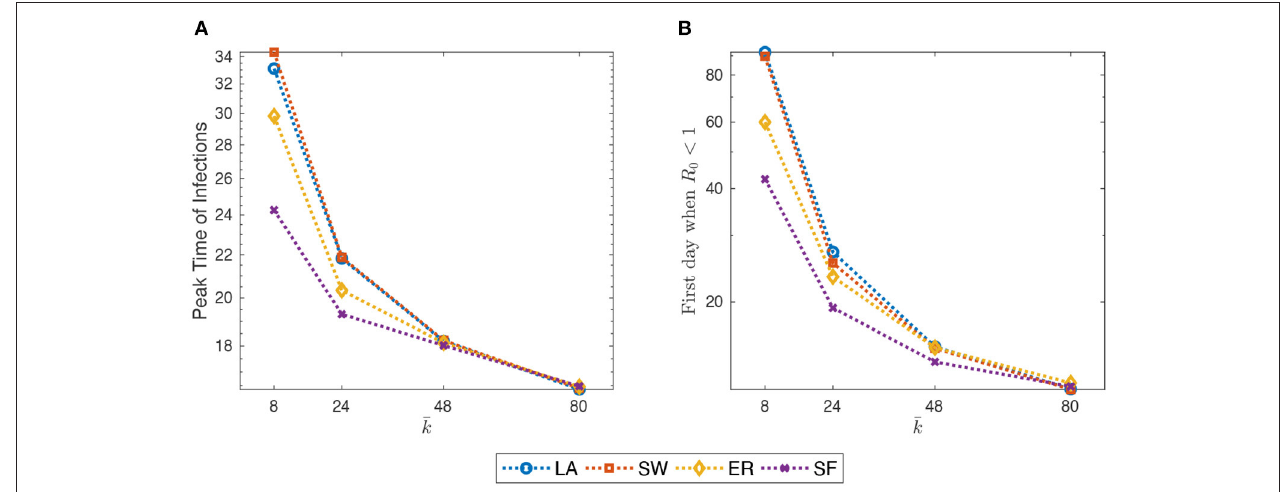
FIGURE 3 | (A) Peak-time of infections (PTI), defined as the first day in which the share of infected people reach its overall maximum, against initial average degree. (B) estimate of the first day after which ¯ ρ goes below one (cf. Supplementary Section S3 ). Initial average degree in the range { 8,24,40,80 } . Mid-impact epidemic scenario. Averages across M = 1,000 Monte Carlo simulations. Y -axis in log